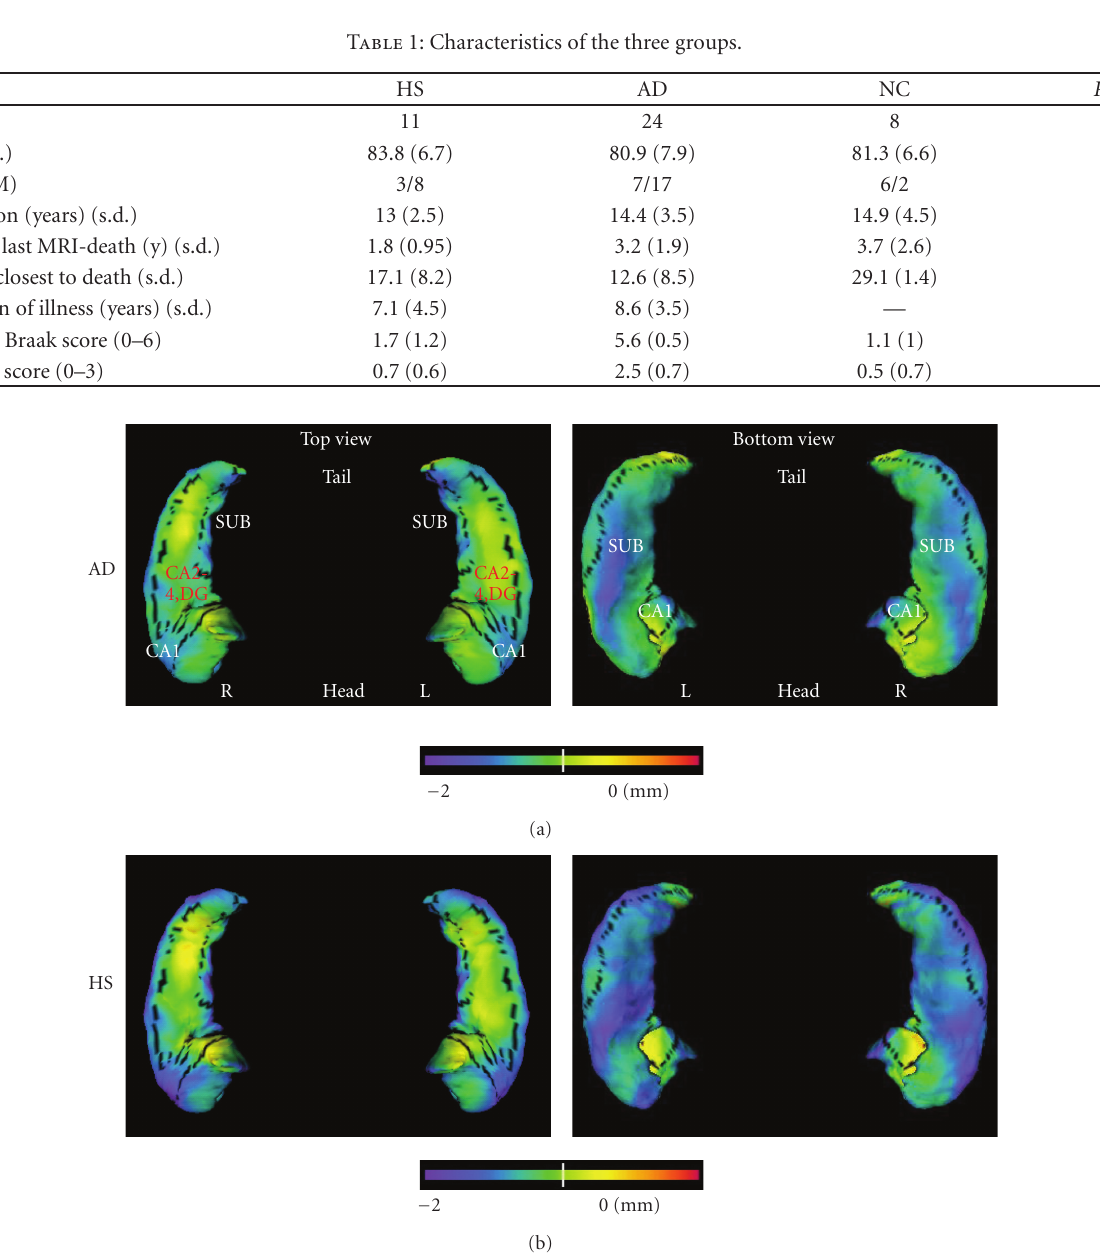
Figure 1: Hippocampal surface deformities in AD (a) and HS (b) compared to NC. Right and left hippocampi are viewed from the top (dorsal surface, left panel) or the bottom (ventral surface, right panel). The flame scale (b) represents the di ff erence between the mean surface of the disease hippocampus and the mean surface of NC hippocampus. Inward deformations are represented by cooler colors (blue to purple), while outward deformations are represented by warmer colors (orange to red). Green to yellow represent near zero deformations. Maximum deformation is 2 mm in either direction. The lateral surface (labeled CA1) is proximal to CA1, where the greatest deformations are found. Labels: SUB = subiculum, CA2-4, DG = combined fields of CA2, CA3, CA4, and the dentate granule cell